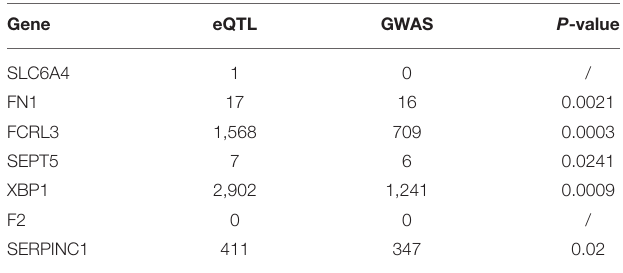
TABLE 3 | The number of SNPs of seven genes in data set.